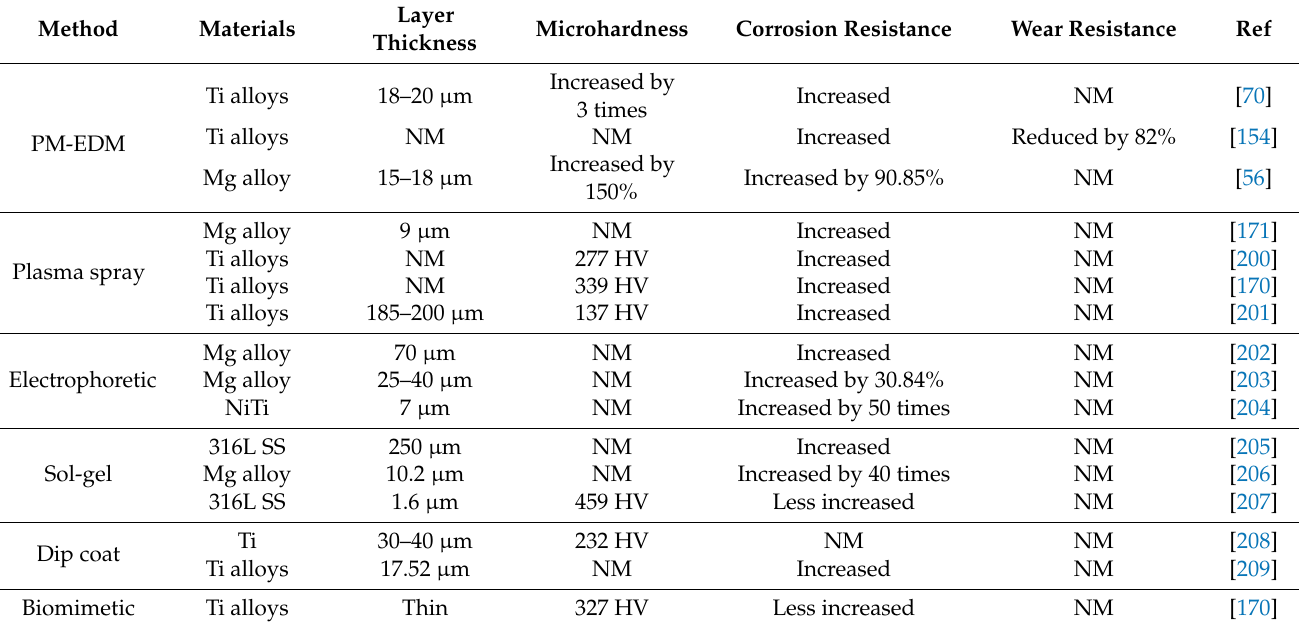
Table 6. Comparative study on HAp-based coating thickness, microhardness, wear and corrosion resistance through different surface modification